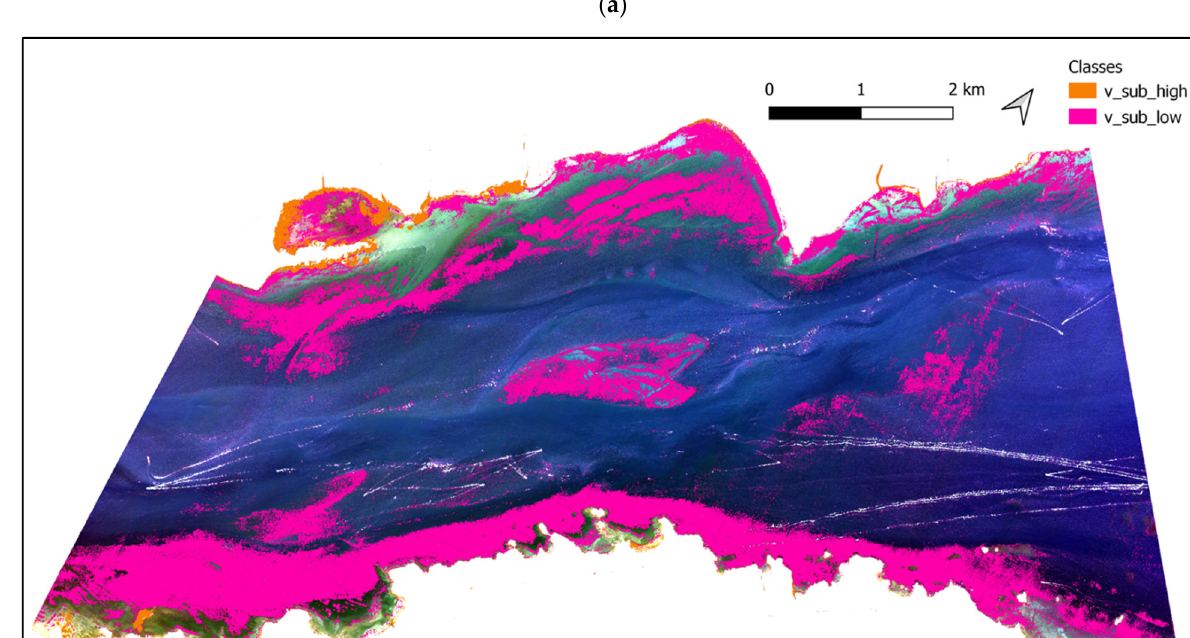
Figure 8. Final vegetation cover map as produced by the proposed workflow. Panel ( a ) shows the 2009 lake Saint-Pierre Quickbird-2 image (© 2022 Maxar Technologies) and panel ( b ) shows the 2019 lake Saint-François image (© 2022 Maxar Technologies).